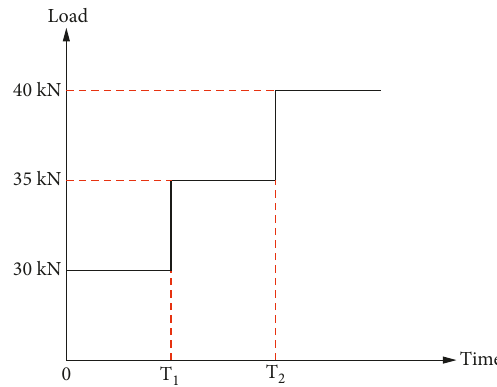
Figure 7: Step loading scheme of creep axial load.